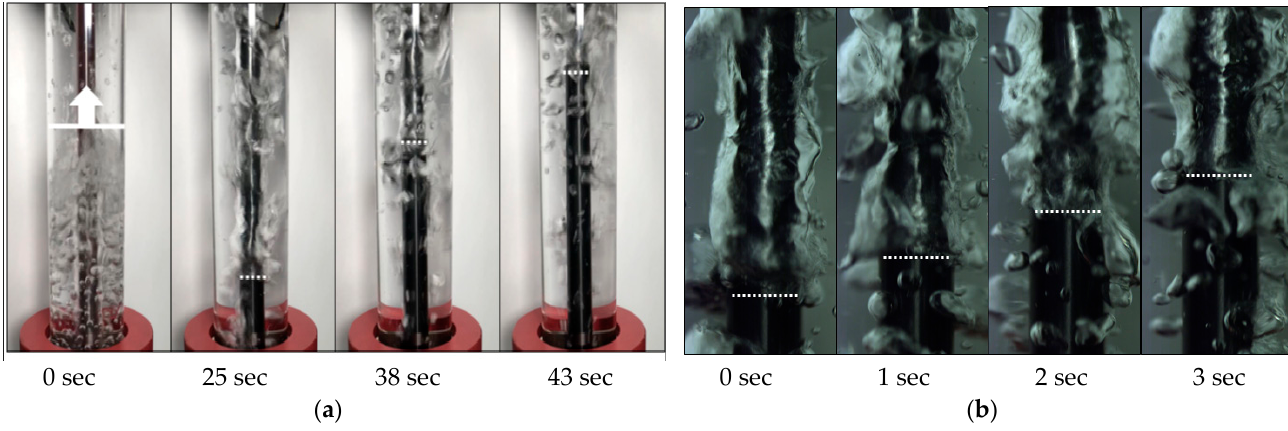
Figure 6. Pictures of the Zr cladding quenching at Tw = 800 °C, T sub = 5 °C and Vc = 0.05 m/s using; ( a ) digital camera; ( b ) high-speed camera.